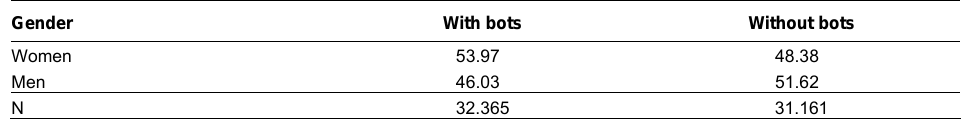
Table 1 : Gender distribution with and without bot correction (column-wise percentages) Gender With bots Without bots 53.97 48.38